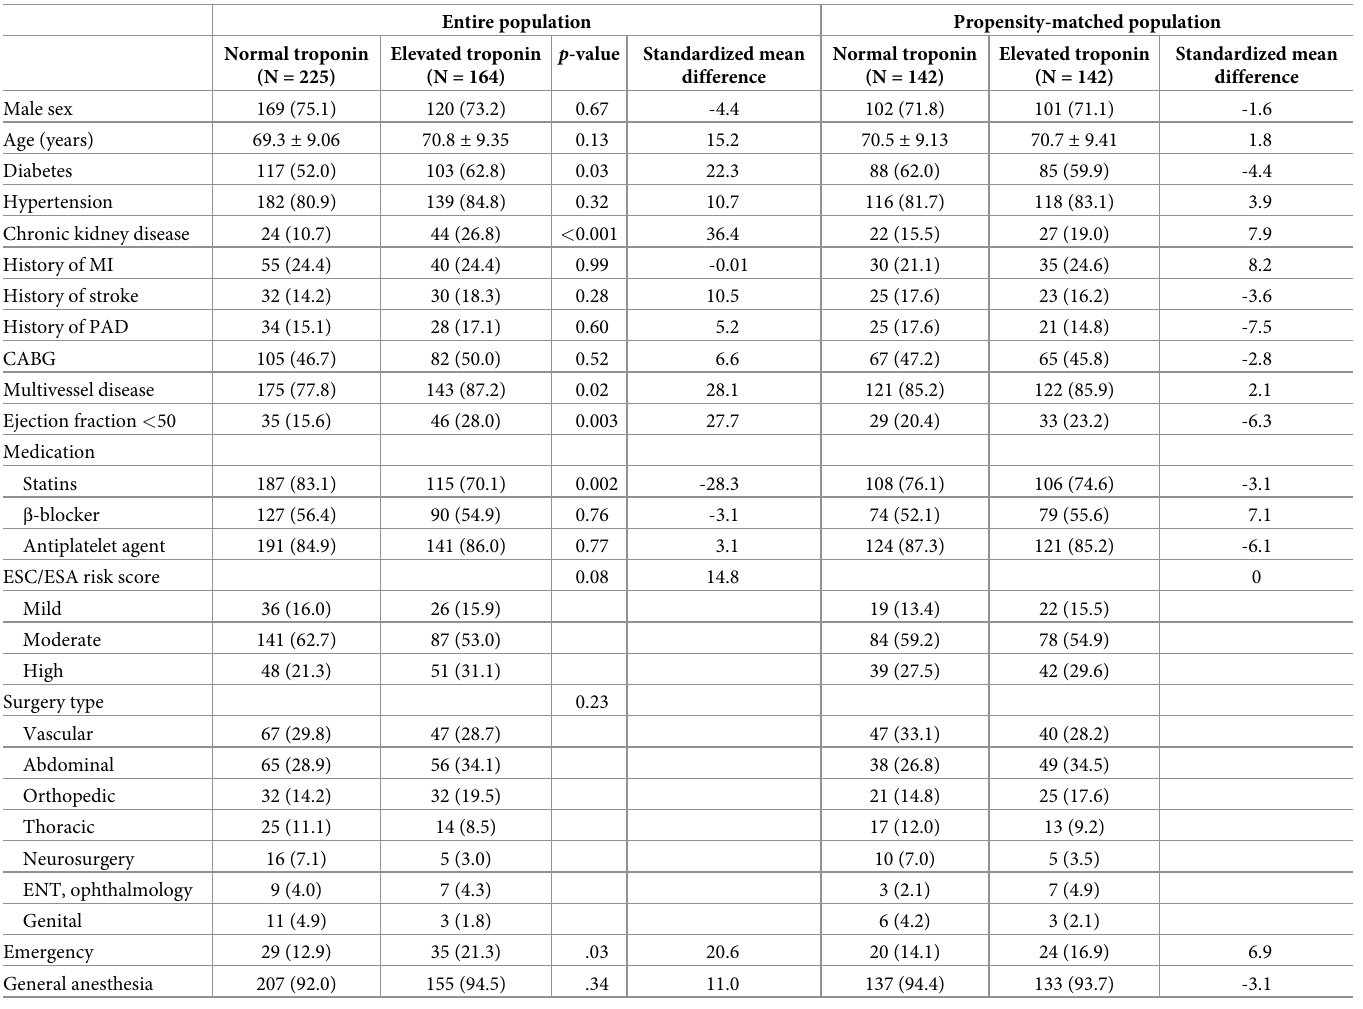
Table 1. Baseline